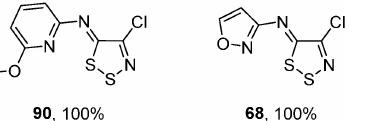
Figure 19. Pyricularia (rice) preventive ≥ 80% efficacy at concentration of 250